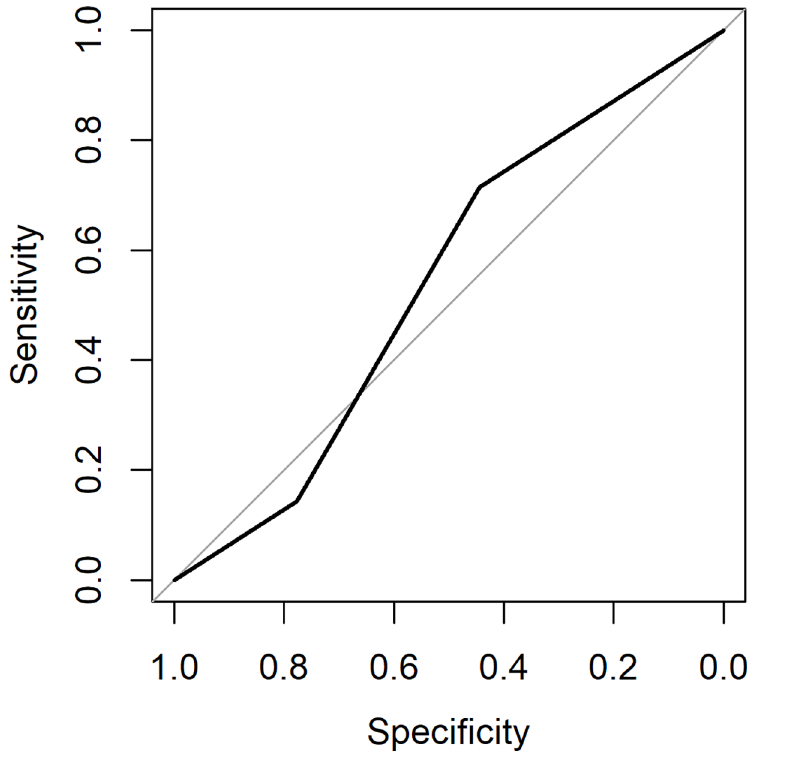
Fig 7. The AUC of the saline block was 0.53 (95% CI: 0.26–0.82).